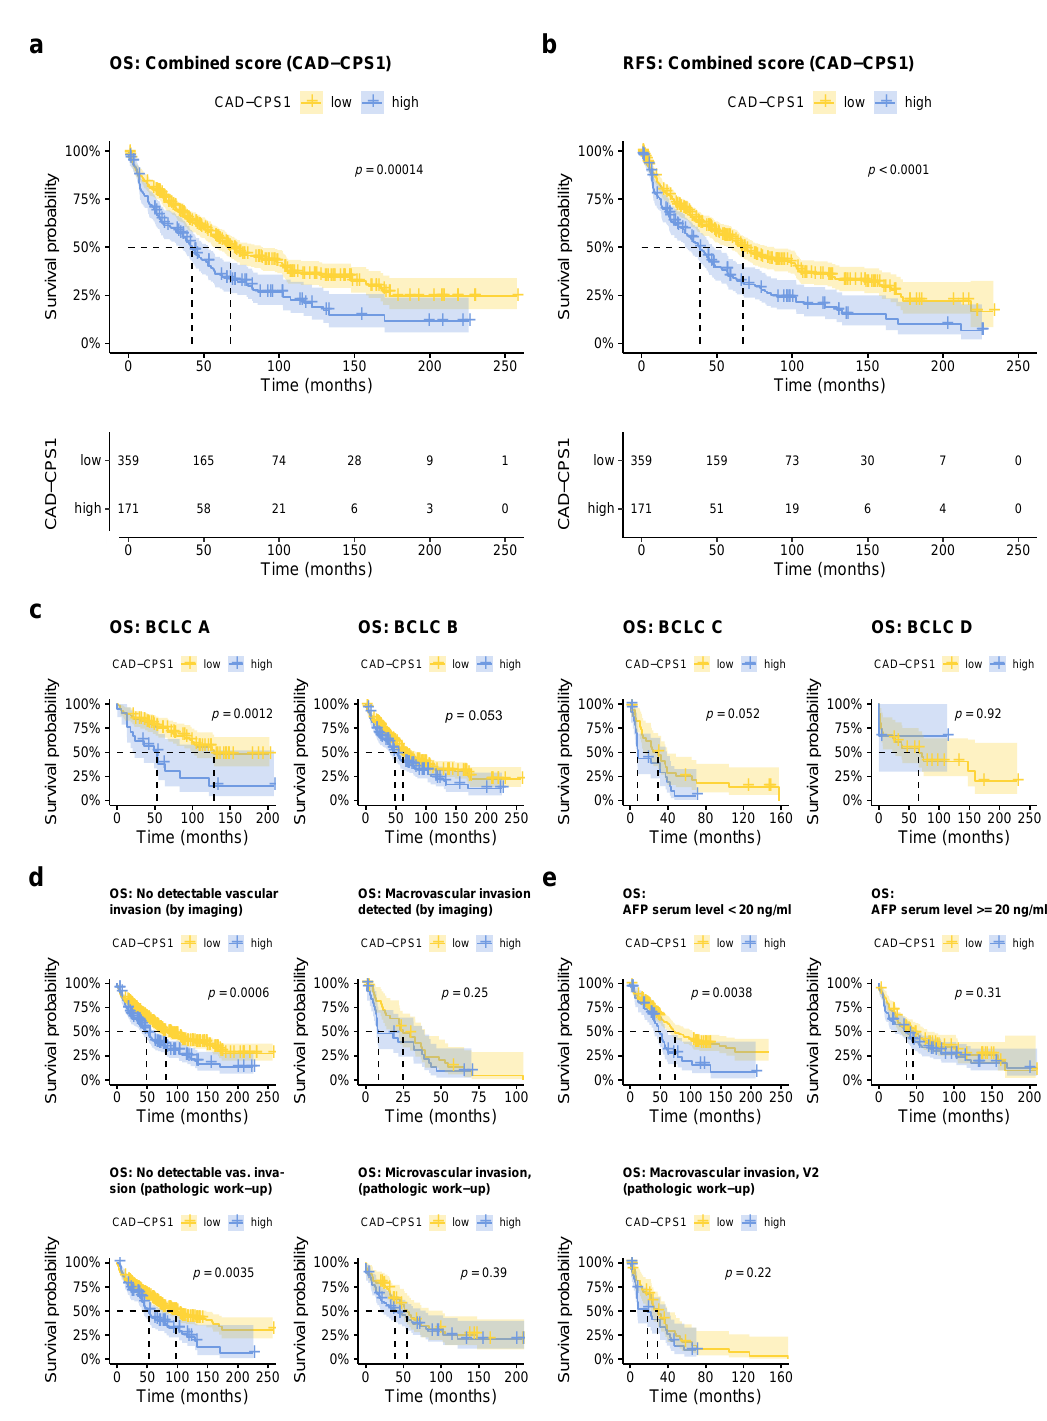
Figure 5. Combining the immunoreactive scores of CAD and CPS1 improves prognostic prediction and is particularly predictive in early stage HCC without vascular invasion. ( a ) Kaplan–Meyer plot showing overall survival rates in patients with respect to a high or low combined CAD-CPS1 score. ( b ) Kaplan–Meyer plot showing recurrence-free survival rates in patients with respect to a high or low combined CAD-CPS1 score. ( c ) Analysis of overall survival in relation to BCLC stage (BCLC A, low: n = 76, high = 21; BCLC B, low: n = 216, high n = 122; BCLC C, low: n = 36, high n = 25, BCLC D, low: n = 31, high: n = 3). ( d ) Analysis of overall survival in relation to macrovascular invasion detected by preoperative imaging (upper two panels, no vascular invasion, low: n = 322, high: n = 144; with vascular invasion, low: n = 37, high: n = 27) and micro- and macrovascular invasion detected during pathologic work-up (lower three panels, V0, low = 259, high: n = 83; V1, low = 53, high = 56; V2, low: n = 47, high: n = 32). ( e ) Overall survival in relation to AFP serum level (AFP < 20 ng/mL, low: n = 198, high: n = 49; AFP ≥ 20 ng/mL, low: n = 93, high: n =